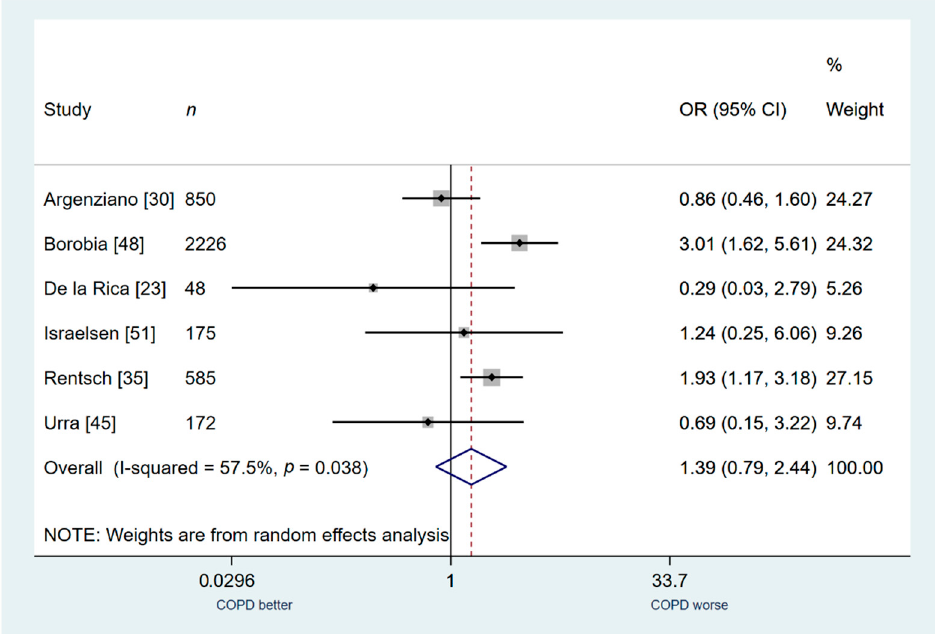
Figure 5. COPD vs. no COPD for the outcome of admission in the ICU.